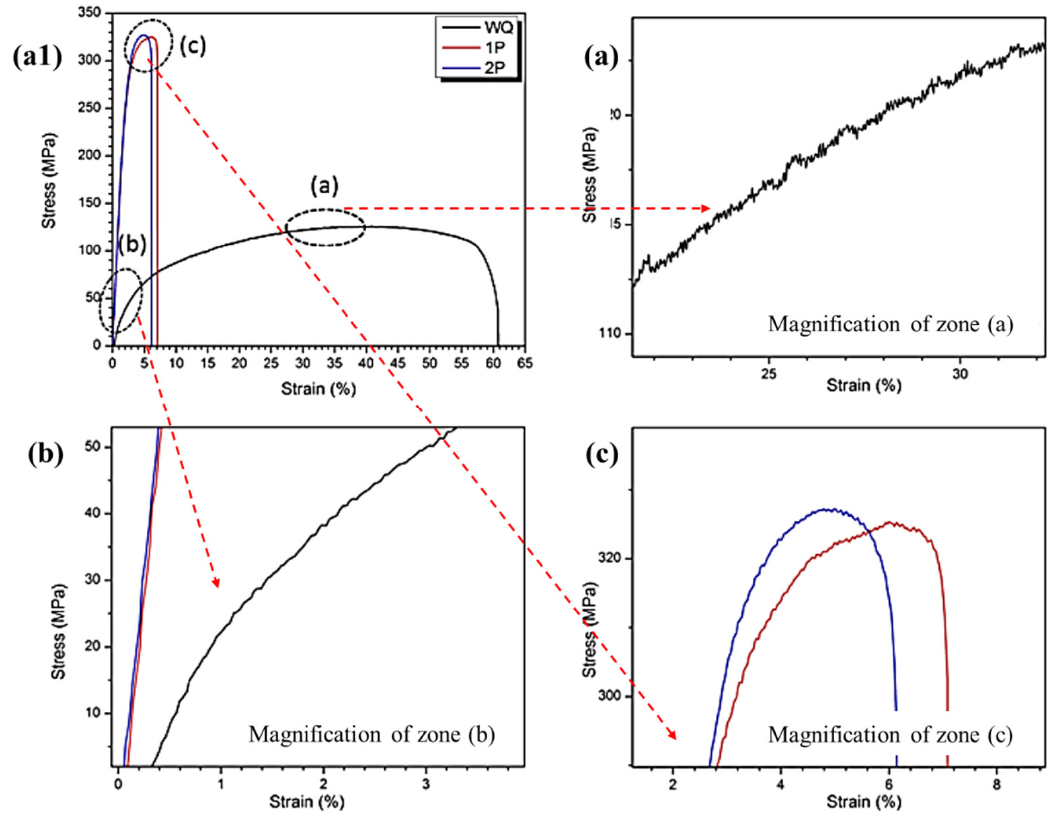
Figure 4. ( a1 ) Stress-strain curve for initial, first-pass, and second-pass CGP-processed Nitinol samples indicating different zones of ( a ) magnification of zone (a) showing plastic region with the deformation twinning in water-quenched condition, ( b ) magnification of zone (b) showing an elastic region of the tensile testing sample, and ( c ) magnification of zone (c) showing the plastic region and the onset of twinning in the first- and second-passes, adapted with permission from [34], 2022, Elsevier (WQ means water quenching).